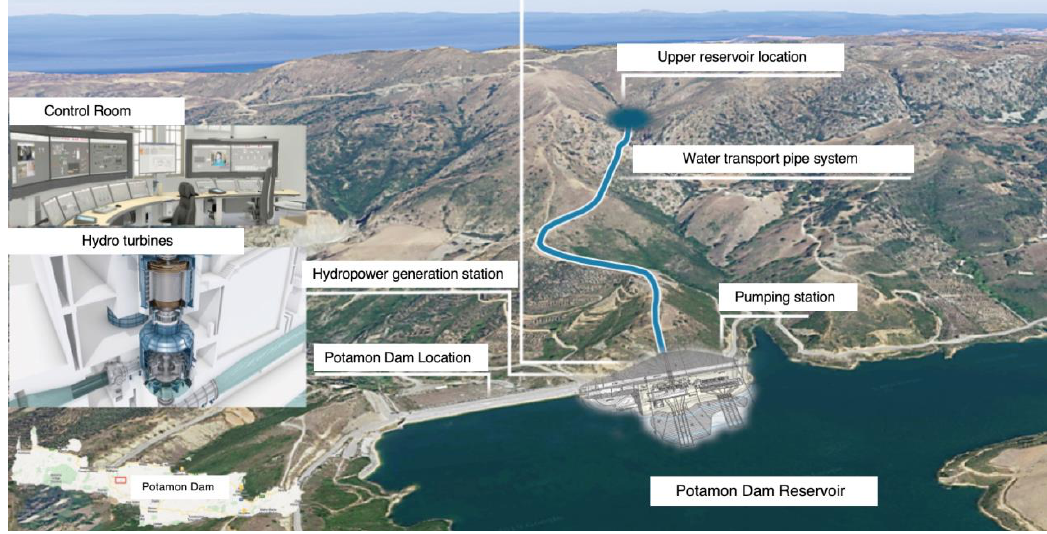
Figure 11. Schematic representation of Pumped Hydro-storage (PHS) in Potamon Dam (modified from [130].